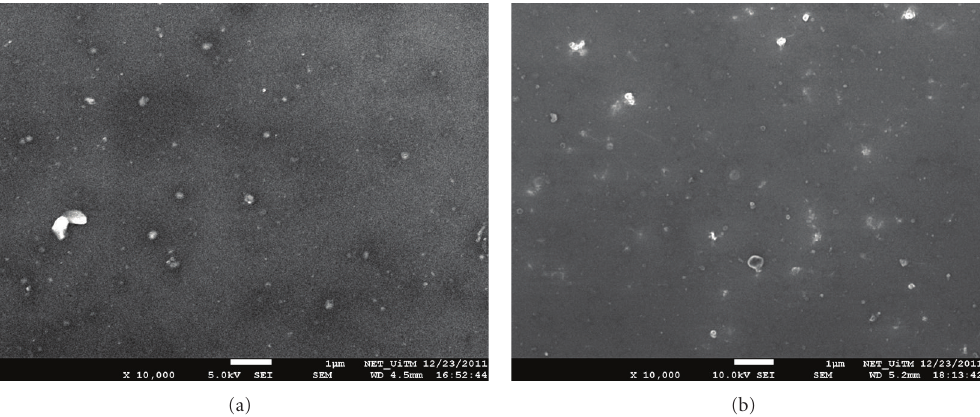
Figure 4: FESEM images of nanocomposited MEH-PPV:CNTs for (a) untreated, (b) treated.